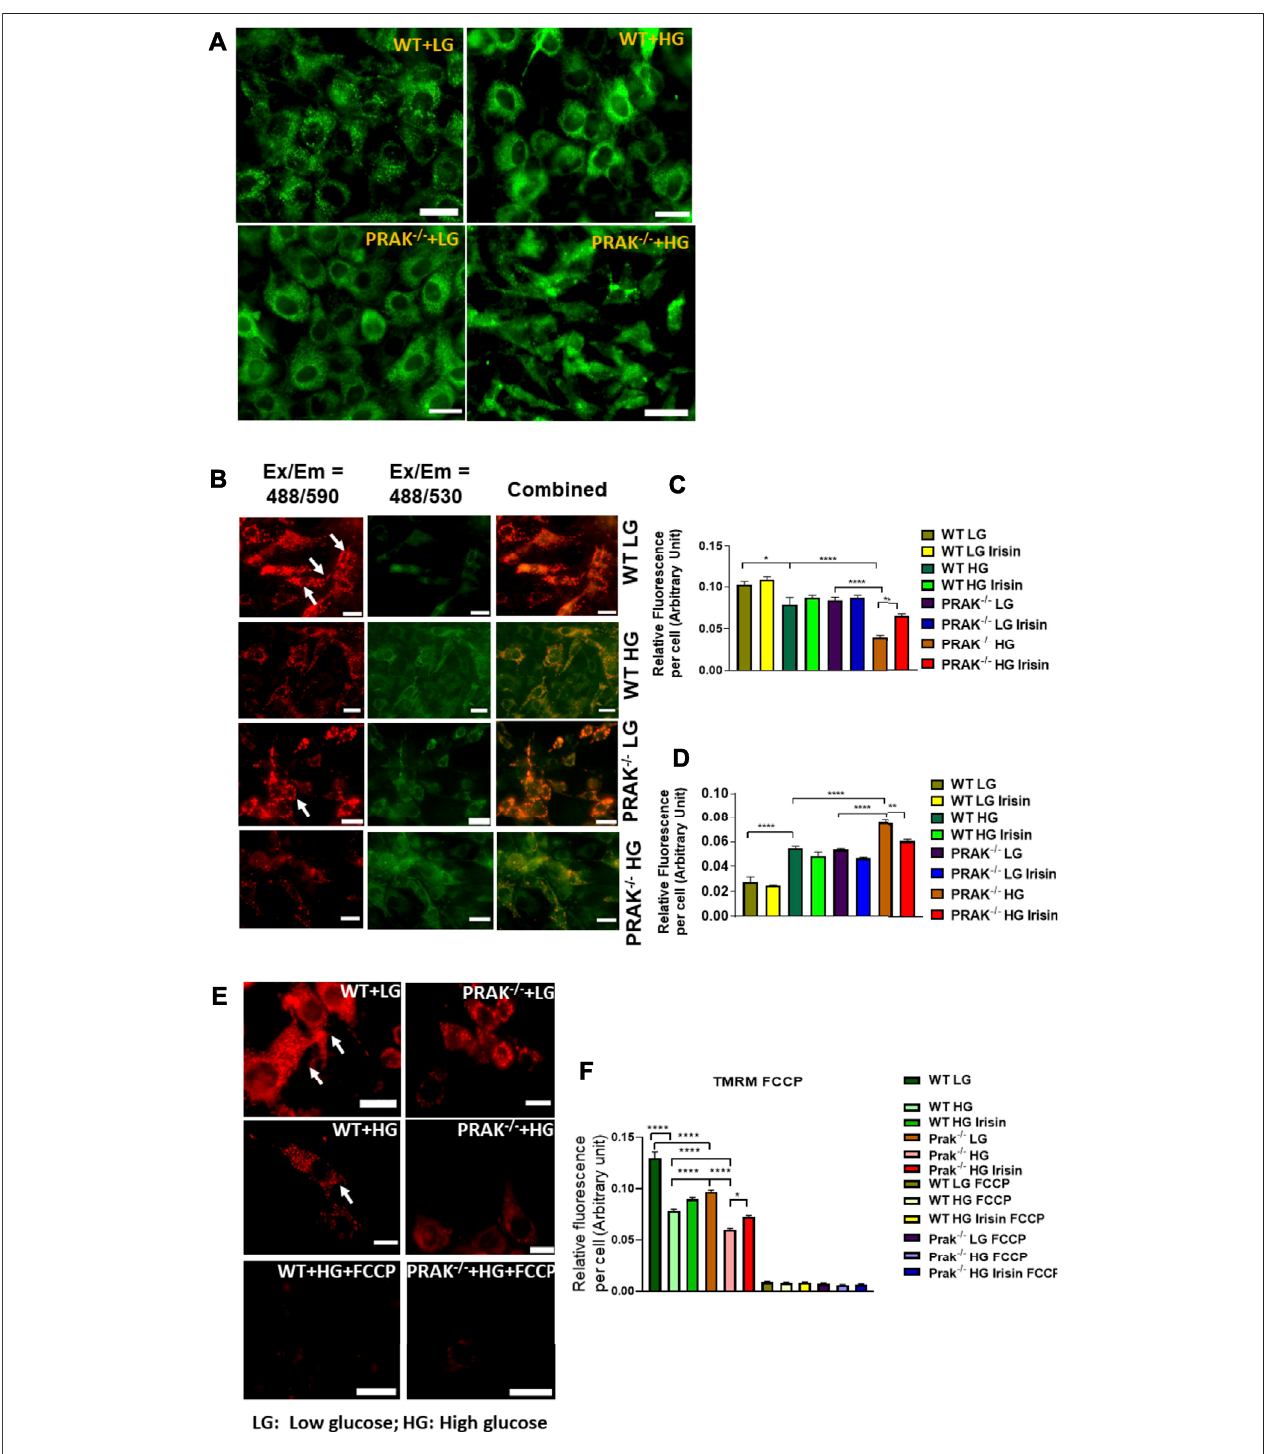
FIGURE 4 | The effect of PRAK knockout on MMP reduction in C2C12 myoblasts exposed to high glucose. (A) : Mitochondrial tracker staining demonstrates the population of mitochondria in both wild type and PRAK − / − C2C12 myoblasts. (B – D) ; Myoblast mitochondrial damage was measured by assessing mitochondrial membrane depolarization. The MitoCapture dye that accumulates in healthy mitochondria emits a red signal, but MitoCapture diffuses into the cytoplasm and emits a green signal when mitochondria were subjected to damage. Exposing C2C12 myoblasts to high glucose resulted in a signi fi cant decrease in the ratio of red to green fl uorescence intensity which indicates a sign of the early stages of cell apoptosis. Fluorescent intensities and representative images in red are shown in Figures 4B,C , respectively, (B,D) : Fluorescent intensities and representative images in green which indicate mitochondrial damage are shown in Figures 4B,D , respectively,